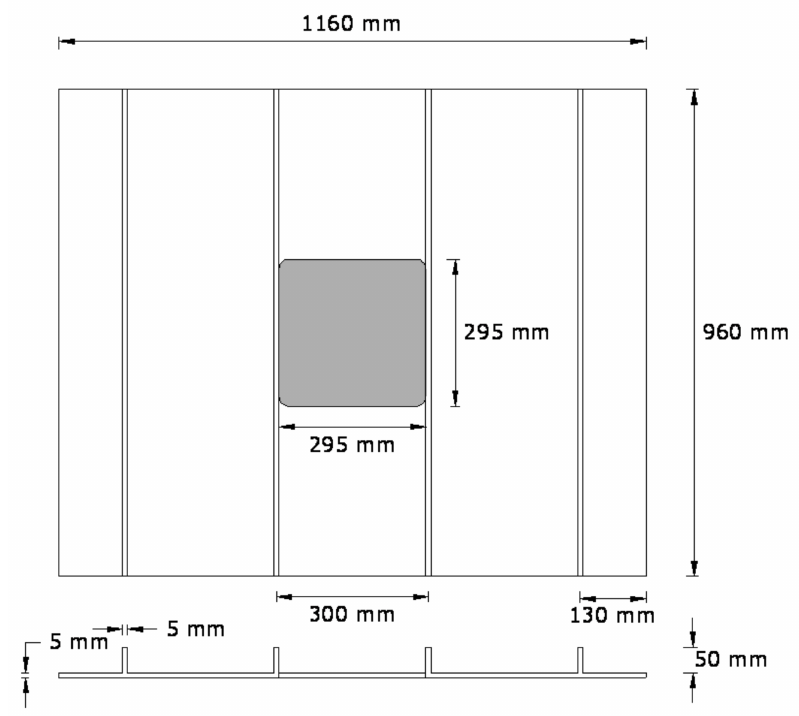
Figure 2. Geometry of glass-fiber-reinforced polymer (GFRP)-stiffened composite plate.